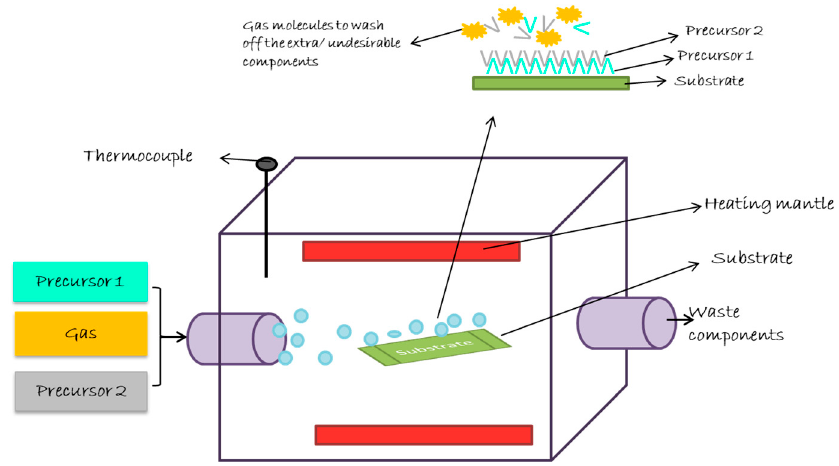
Figure 24. Schematic illustration of working mechanism of atomic layer deposition to coat a substrate. The major components of this process are as follows: two precursors, gas, thermocouple, heating mantle, and inlet and outlet for gaseous compounds.